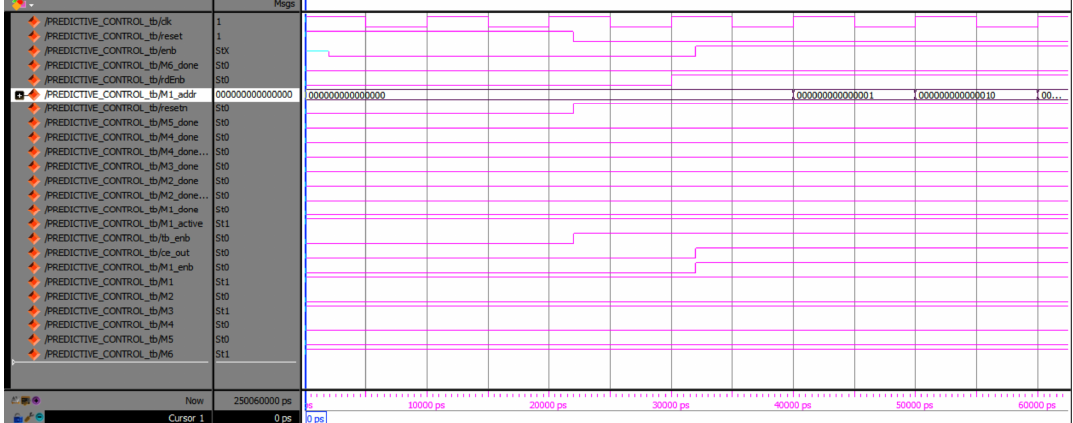
Figure 22. RTL simulation output of FS-PDCC using Modelsim ® .